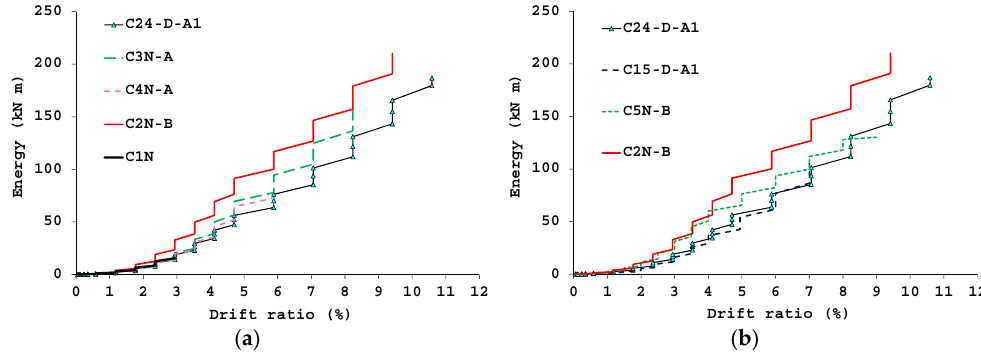
Figure 19. Energy dissipation: specimens subjected to ν = 0.40 ( a ) and comparison between systems “type B” and “type A1” ( b ).